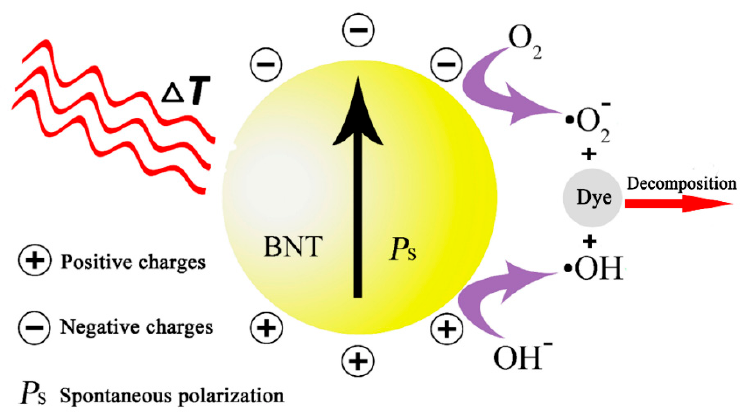
Figure 6. The mechanism diagram of the pyro-catalytic dye decomposition with BNT.